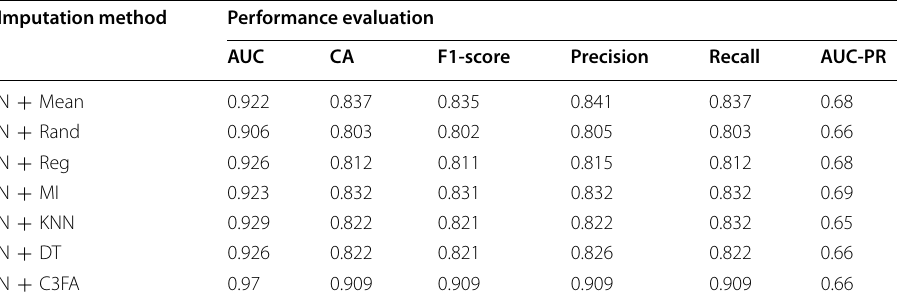
Table 3 Evaluation results using AUC, accuracy, F1-score, precision, recall, and AUC-PR for normalization +